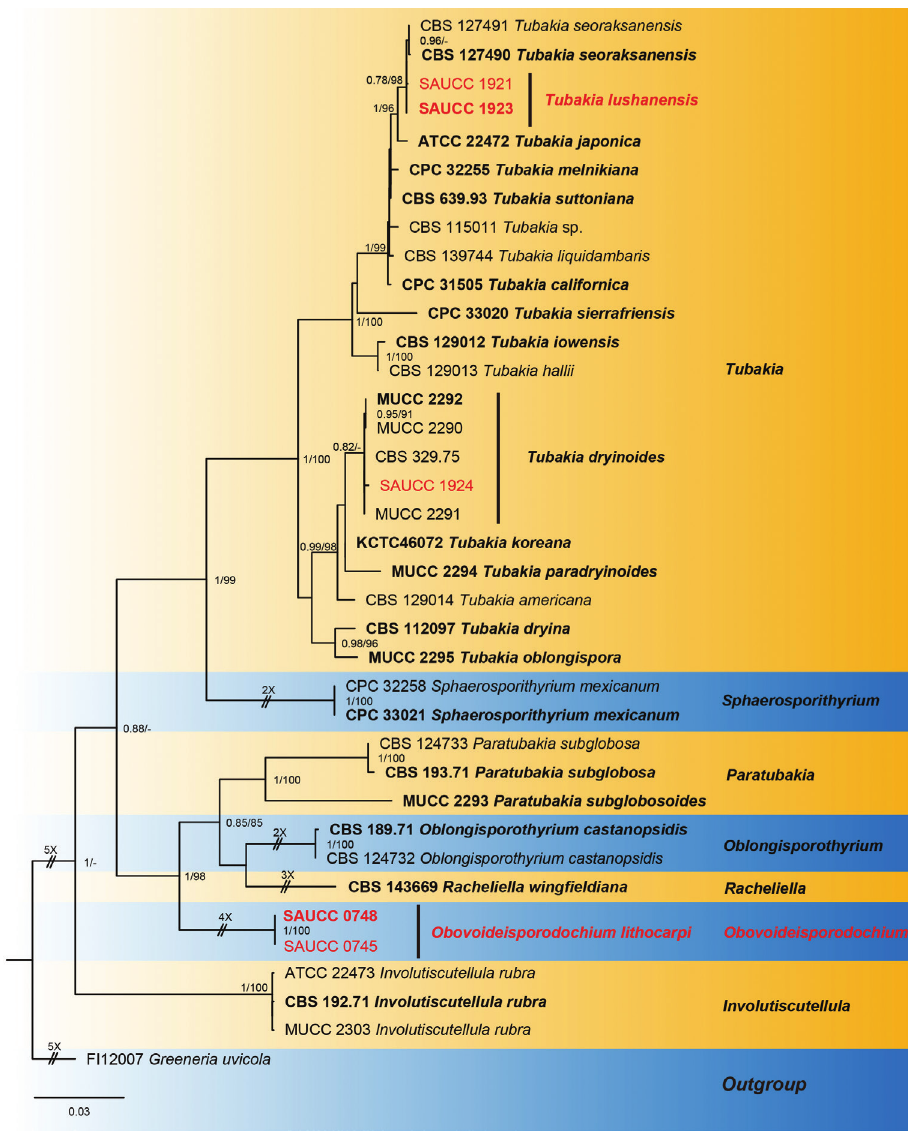
Figure 1. Phylogram of Tubakiaceae, based on the concatenated ITS, LSU and rpb2 sequence alignment. The BI and ML bootstrap support values above 0.74 and 74% are shown at the first and second position, re- spectively. The tree is rooted to Greeneria uvicola (culture FI12007) and ex-type cultures are indicated in bold face. Strains from the current study are in red. Some branches were shortened for layout purposes – these are indicated by two diagonal lines with the number of times a branch was shortened indicated next to the lines.